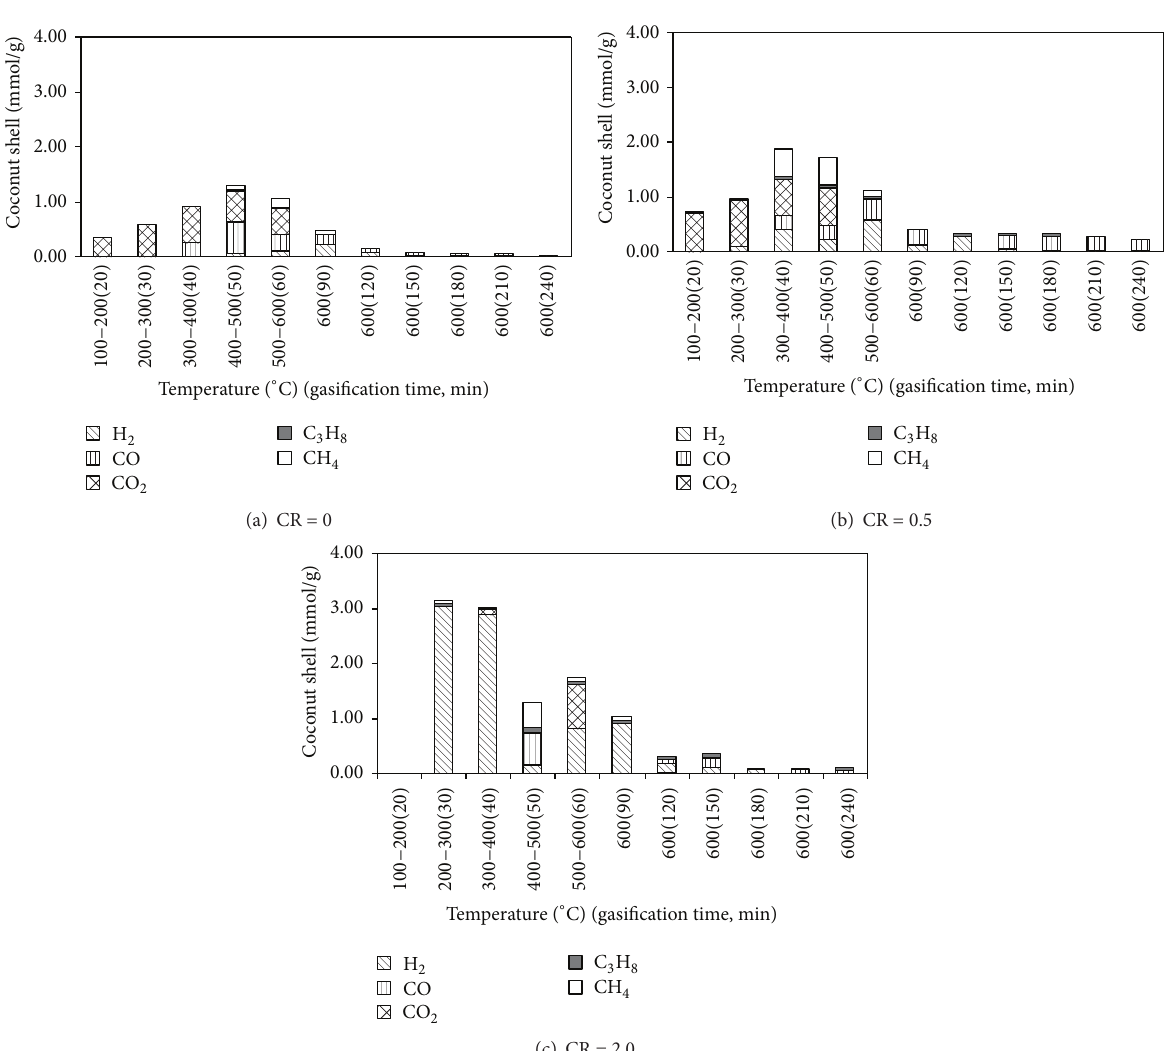
composition of 19.07% does not greatly differ from the values of 18.75% and 23.3%, as reported by Yang et al. (2010) [27]